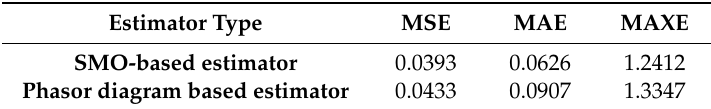
Table 9. Performance indices of the SMO-based estimator and the phasor diagram based estimator during dynamic disturbances of active power for generator operating point P = 0.89, Q = 0.